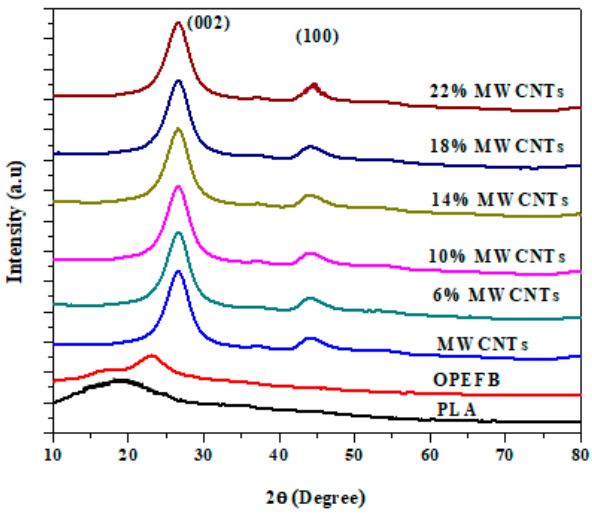
Figure 4. XRD pattern of OPEFB, PLA, MWCNTs, and OPEFB / PLA / MWCNTs composites with di ff erent concentrations of MWCNTs .